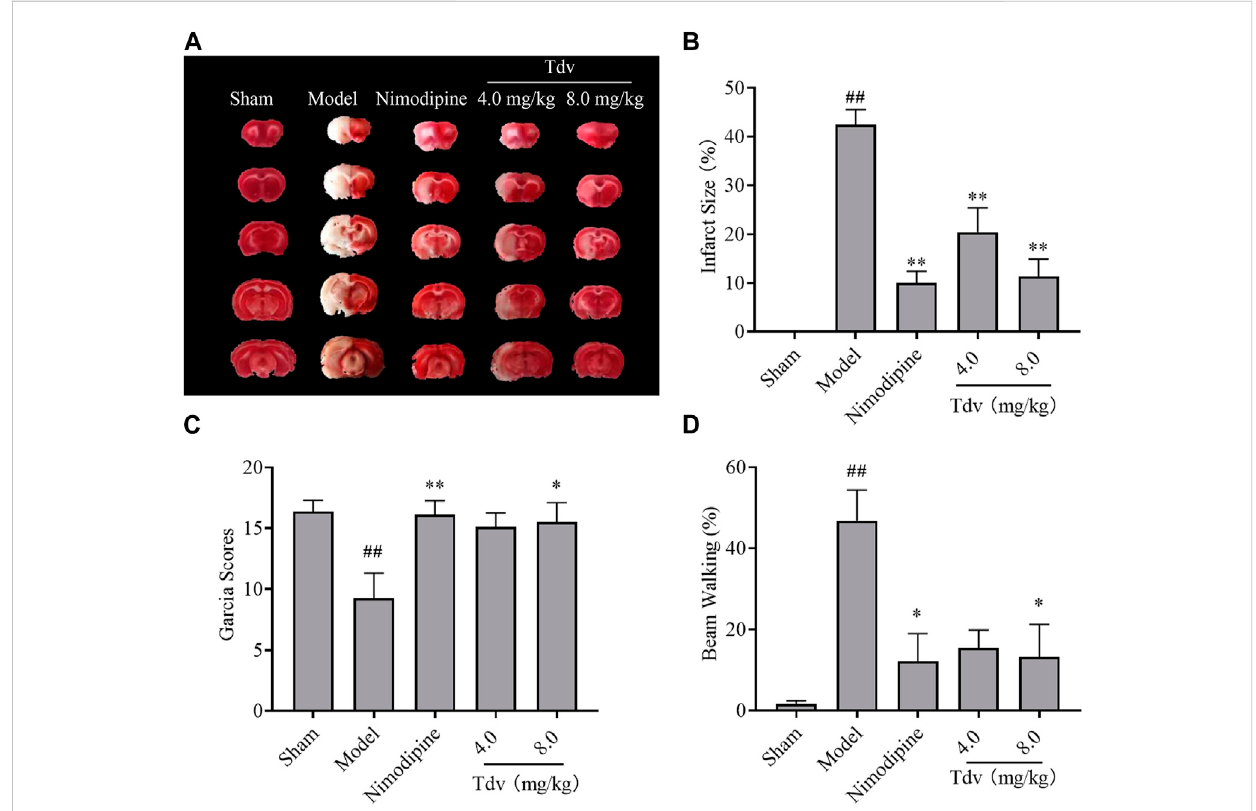
Toludesvenlafaxine alleviated neurological de fi cits and reducedcerebralinfarction size. (A) TTC staining; (B) Cerebral infarct size; (C) Garcia Scores; (D) Beam-walking test. Data were expressed as mean ± SD and behavioral tests were expressed as medium ± range, n = 8. ## p < 0.01 compared with sham group; * p < 0.05, ** p < 0.01 compared with model